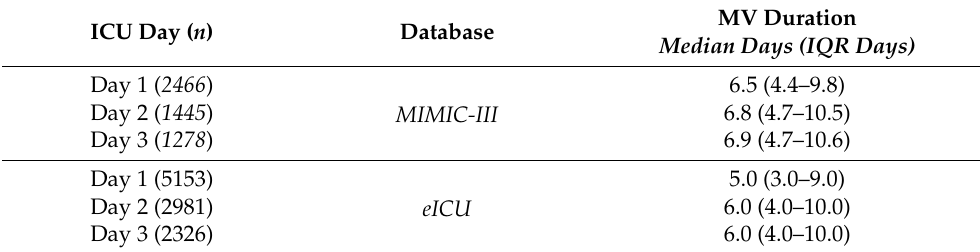
Table 2. MV Duration in ARDS across MIMIC-III and eICU.